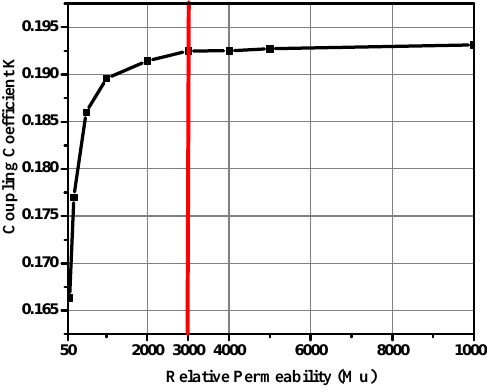
Figure 5. Coupling coefficient and the magnetic core’s relative permeability.